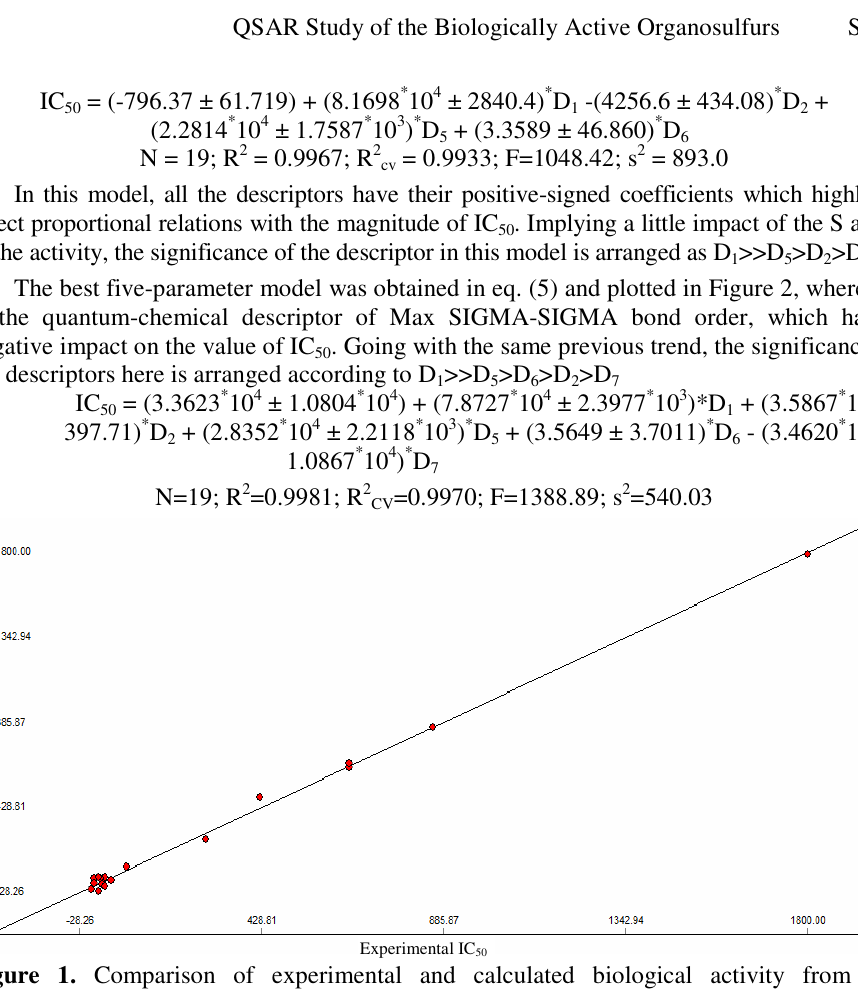
= 0.9933; F=1048.4; s 2 = 892.95 for 19 cv